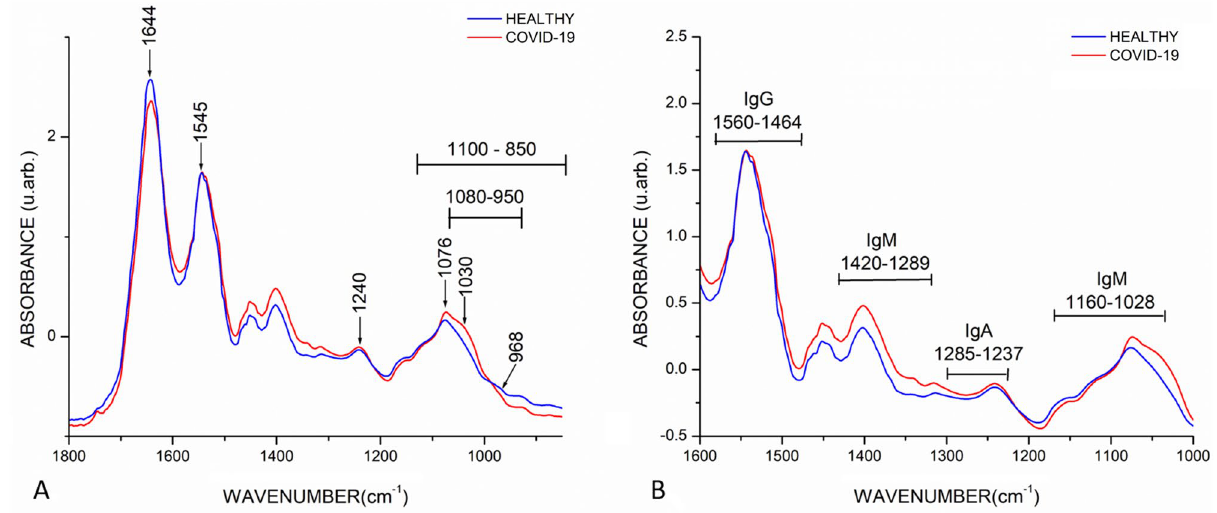
Figure 1. Mean of FTIR spectra of healthy (N = 1209) and COVID-19 (N = 255) groups. ( A ) Biological fingerprint region, diverse absorption bands related to biological samples are evidenced such as Amide I (1644 cm −1 ), Amide II (1545 cm −1 ), and Amide III (1240 cm −1 ), as well as phosphorylated molecules (1240 cm −1 and 1076 cm −1 ), carbohydrates (1030 cm −1 ), and DNA backbone (968 cm −1 ). Likewise, ranges at 1100–850 cm −1 and 1080–950 cm −1 attributed to nucleic acids and α-amylase respectively were observed. Differences in absorbance and displacements between the bands of the groups representing changes in biochemical compositions were evidenced. ( B ) Immunoglobulins regions, different immunoglobins intervals were detected such as IgG (560–1464 cm −1 ), IgM (1420–1289 cm −1 and 1160–1028 cm −1 ), and IgA (1285–1237 cm −1 ), noticing that the COVID-19 group exhibited a higher absorbance.